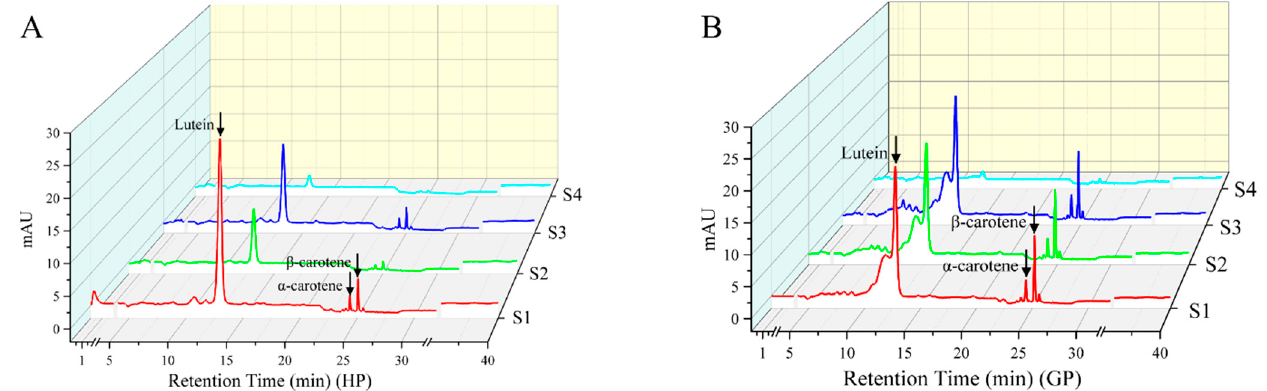
Figure 1. HPLC profiles of carotenoid compositions in young pomelo fruits. ( A ) Honey pomelo; ( B ) Golden pomelo. S1~S4 indicate different developmental stages.